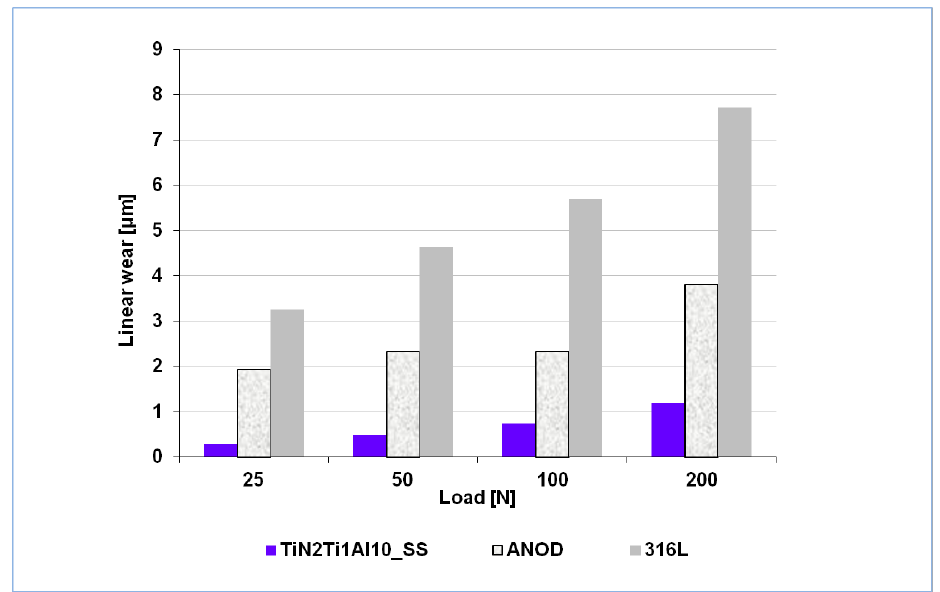
Figure 9. Wear resistance in Amsler test of the composite titanium nitride layer (TiN2Ti1Al10_SS) compared to stainless 316L steel and commercially anodized AZ91D magnesium alloy.